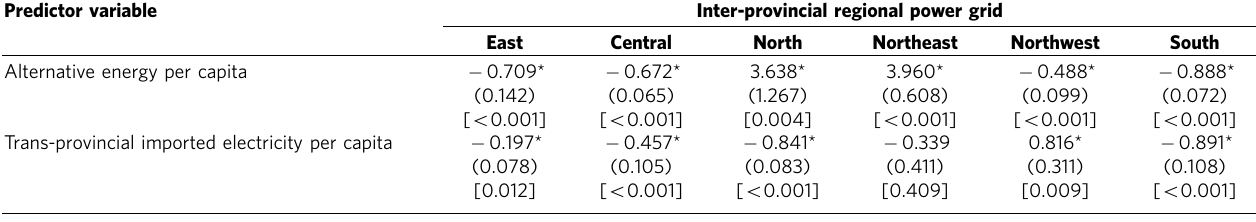
Shown are displacement coefficients estimated from panel analyses of data from 30 provinces and municipalities during 1995–2014, where the electricity demand is modelled as controlled by GDP per capita. Full results for the model are presented in Supplementary Table 4. *Statistically significant at the 0.05 alpha level (two-tailed test), s.e.’s are reported in parentheses, while P values are presented in brackets.